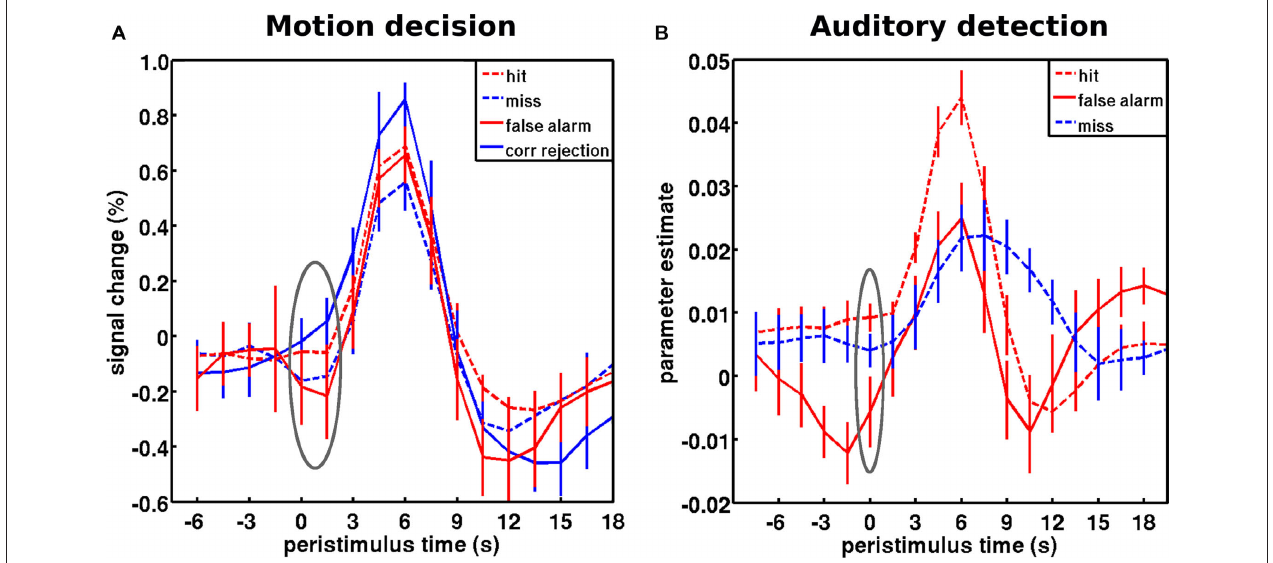
FIguRe 5 | Baseline activity levels in false vs. correct inferences are captured by the predictive coding framework. (A) Peristimulus fMRI signal time courses from the motion decision experiment: for stimuli and region of interest cf. Figure 3C . Hits and misses correspond to trials at threshold motion coherence level (on average 13%), while correct rejections and false alarms correspond to occasional trails with a quasi-random coherence level (1%). Pre-stimulus activity showed a main effect of accuracy, correct vs. incorrect (consistent with predictive coding), but no main effect of percept, coherent vs. incoherent (predicted by evidence accumulation). Pre-stimulus activity prior to hits was significantly greater than misses; and pre-stimulus activity in false alarms were significantly less than in correct rejects. (B) Peristimulus time courses from the auditory detection experiment: for stimuli and region of